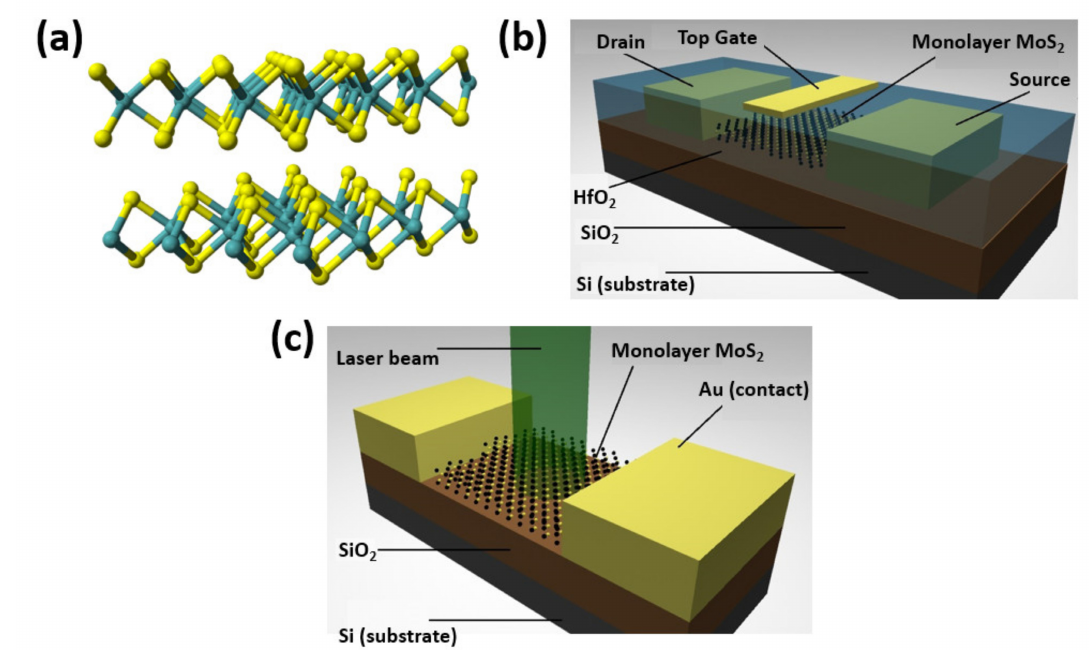
Figure 3. ( a ) Structure of 2-D Quantum dots. ( b ) Field effect transistor based on monolayer of MoS 2 . ( c ) Photodetector based on a monolayer of MoS 2